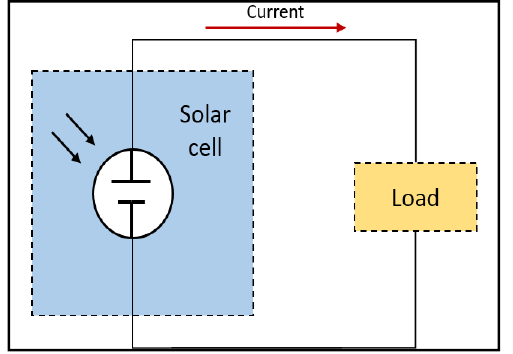
Figure 1. Real-time direct light solar radiation spectrum for atmosphere and sea level.